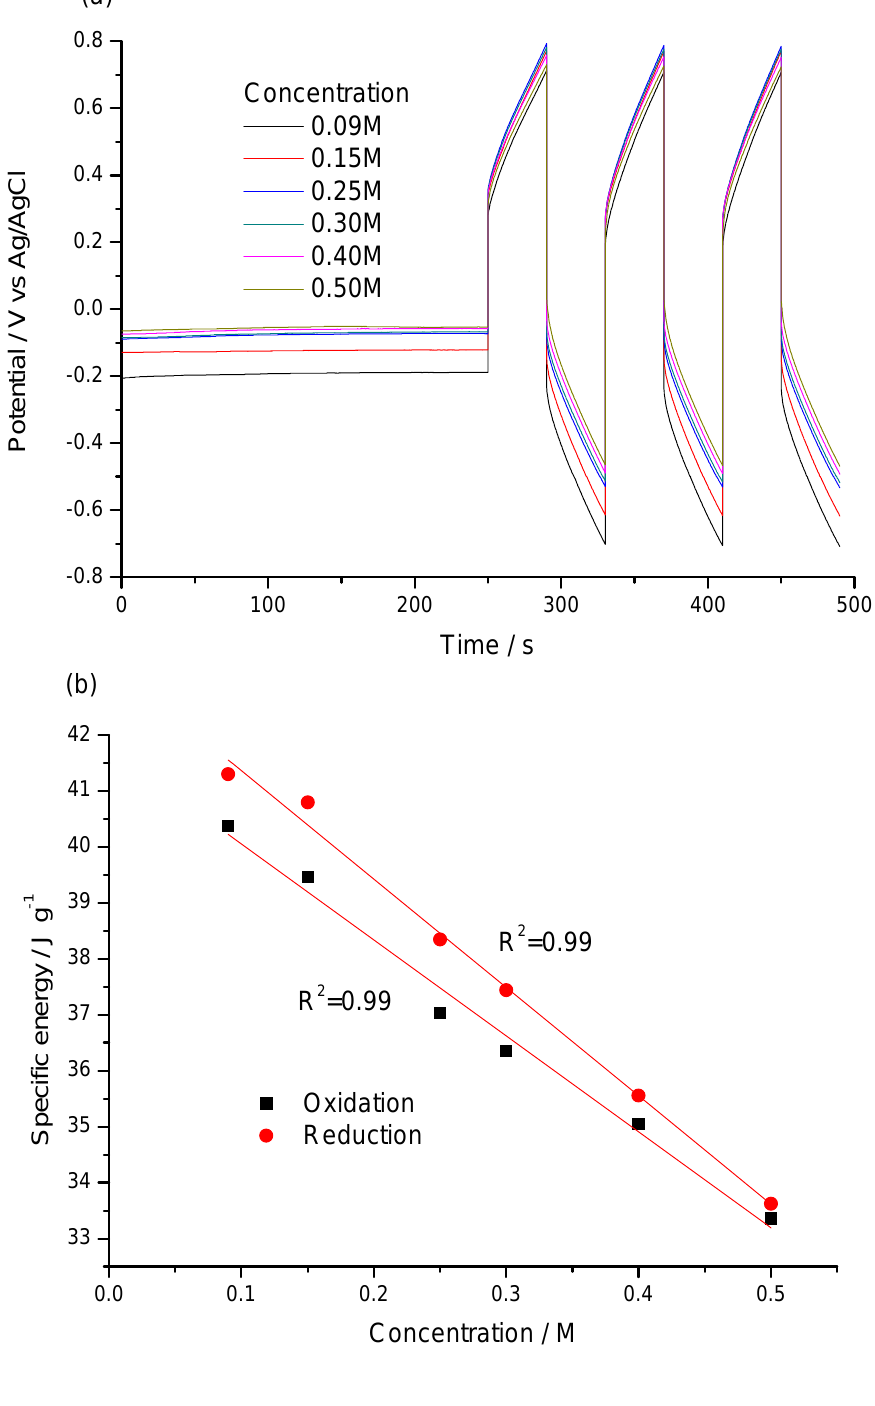
Figure 10. (a) Chronopotentiograms obtained from pPy/DBSA self-supported films for concentrations. After stabilization of the initial oxidation state by different LiClO 4 applying a constant current of –0.01 mA for 250 s, square current waves of ±2.25 mA flowing for 40 s per step, are applied to a pPy/DBSA film. (b) Variation of the electrical energy as a function of the electrolyte concentration. R 2 is the correlation coefficient of the linear